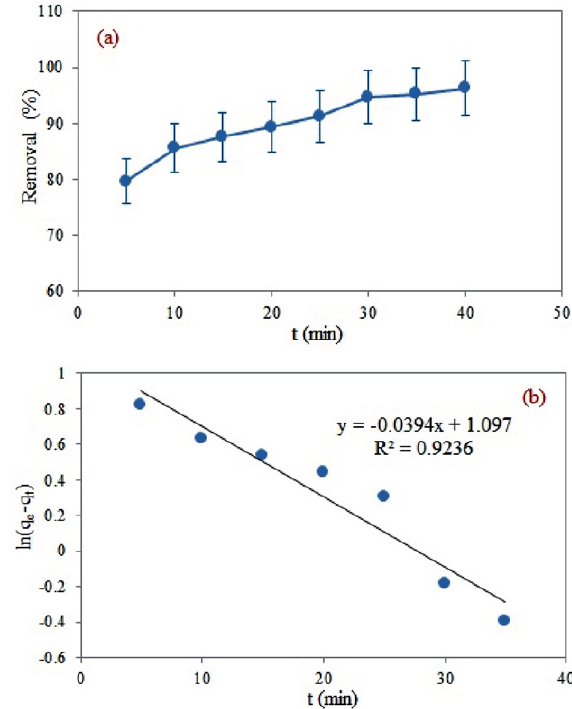
Figure 4. (a) Effect of contact time on MB adsorption by nanozeo- lite L, (b) Pseudo-first-order kinetics plots for adsorption of MB by nanozeolite L and (c) Pseudo-second-order kinetics plots for ad- sorption of MB by nanozeolite